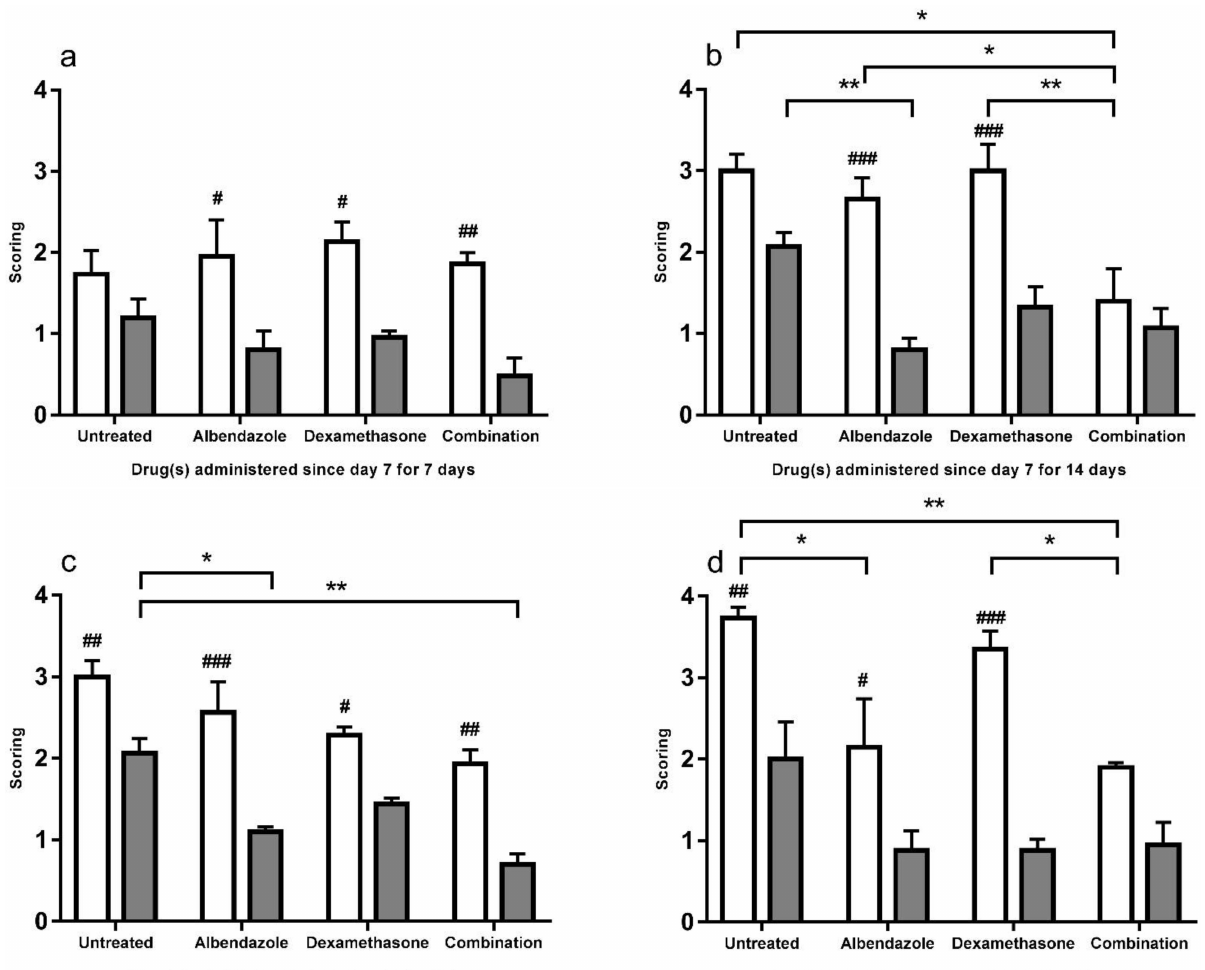
Figure 10. Scorings of meninges congestion and hemorrhage in the cerebral parenchyma of the BALB/c (white) and C57BL/6 (gray) untreated mice and those treated with albendazole alone dexamethasone alone, and co-therapy of the two drugs after infection with Angiostrongylus cantonensis . Data are expressed as mean ± standard error of the mean (Untreated group vs. albendazole group vs. dexamethasone group vs. co-therapy group, * p < 0.05, ** p < 0.01) (BALB/c mice vs.